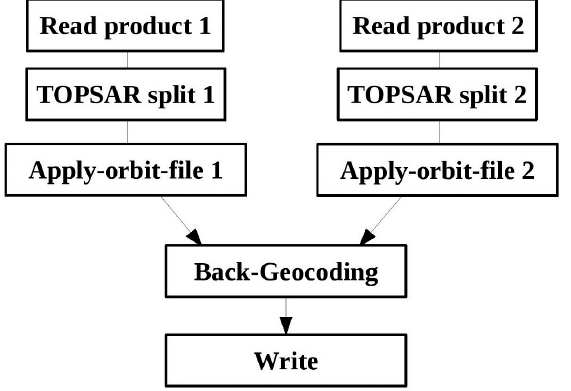
Figure 5. Co-registration block diagram.